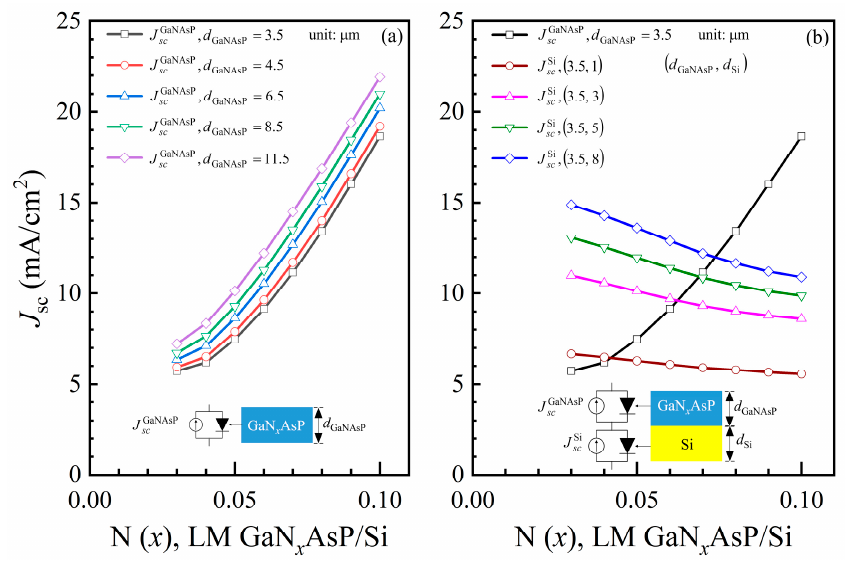
Figure 5. ( a ) Calculated short current densities of Si-lattice-matched GaN x AsP (LM GaN x AsP/Si) cells short current densities ( J GaNAsP sc ) as a function of N mole fraction; ( b ) Short current densities ( J sc ) of 3.5 µ m thick GaNAsP top cell ( J GaNAsP sc ) and Si bottom cell ( J Si sc ) with different thicknesses as a function of N concentration.